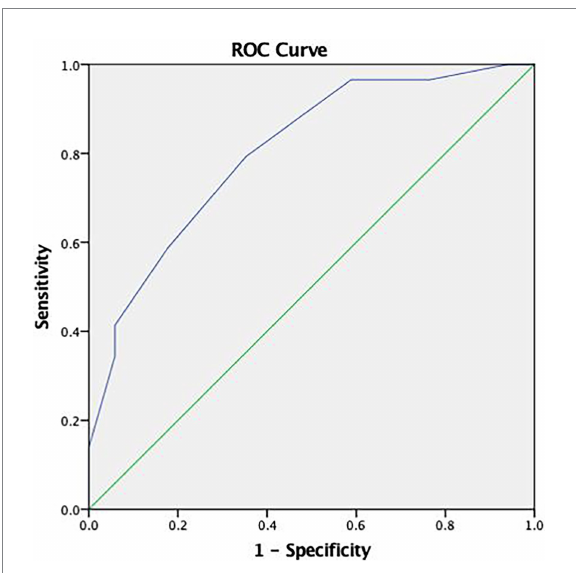
FIGURE 1 Receiver operating characteristic (ROC) curve concerning the discriminative capacity of the Reliable Digit Span (RDS).